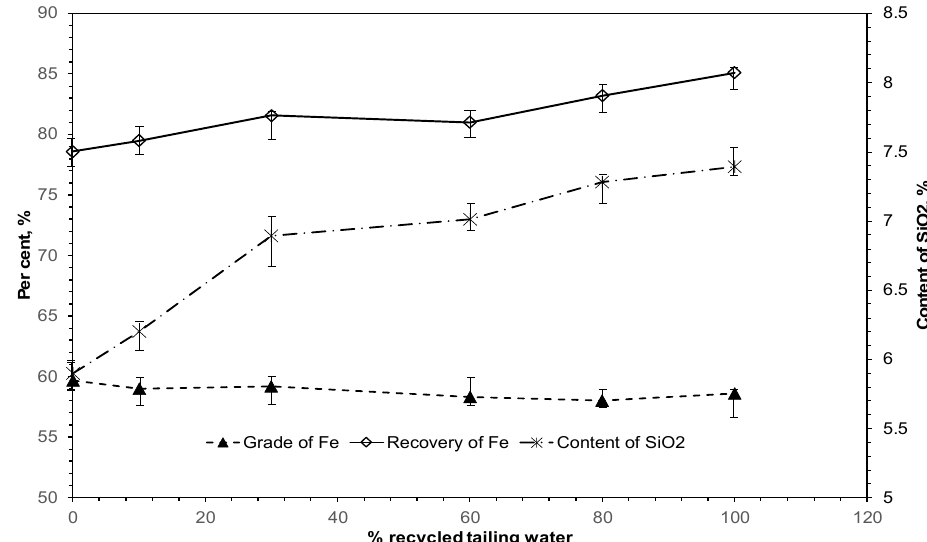
Figure 2. The effects on the grade/recovery of Fe and content of SiO 2 in concentrate as a function of % recycling tailing water.